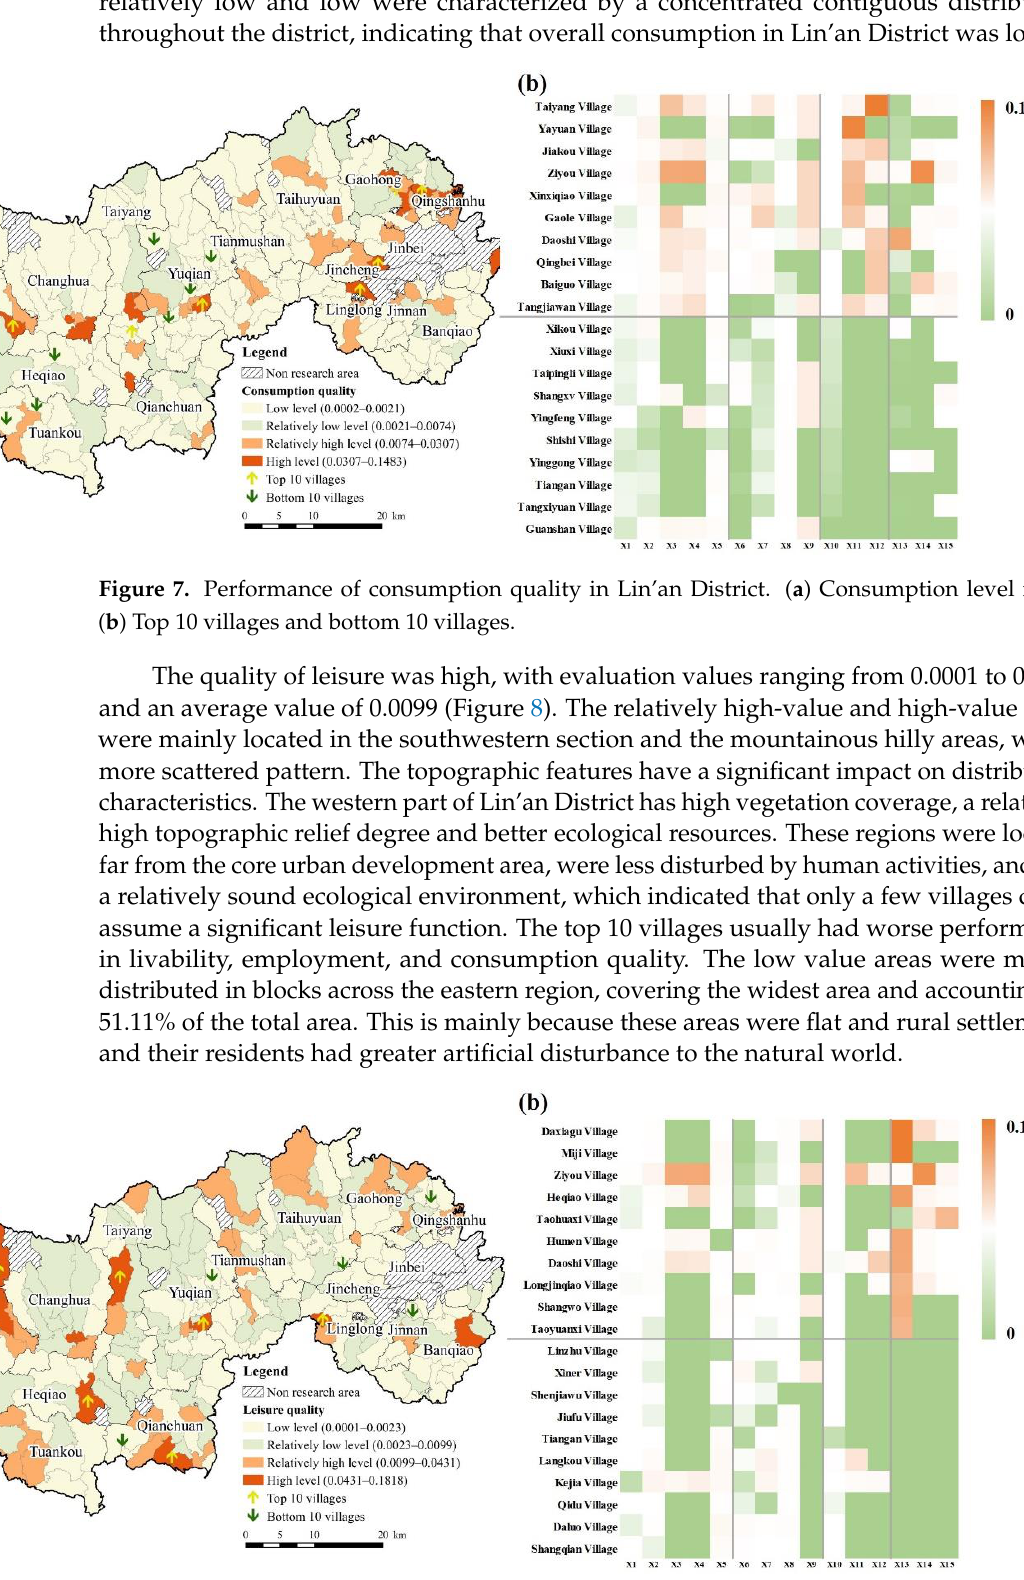
Figure 8. Performance of leisure quality in Lin’an District. ( a ) Leisure culture index. ( b ) Top 10 villages and bottom 10 villages.